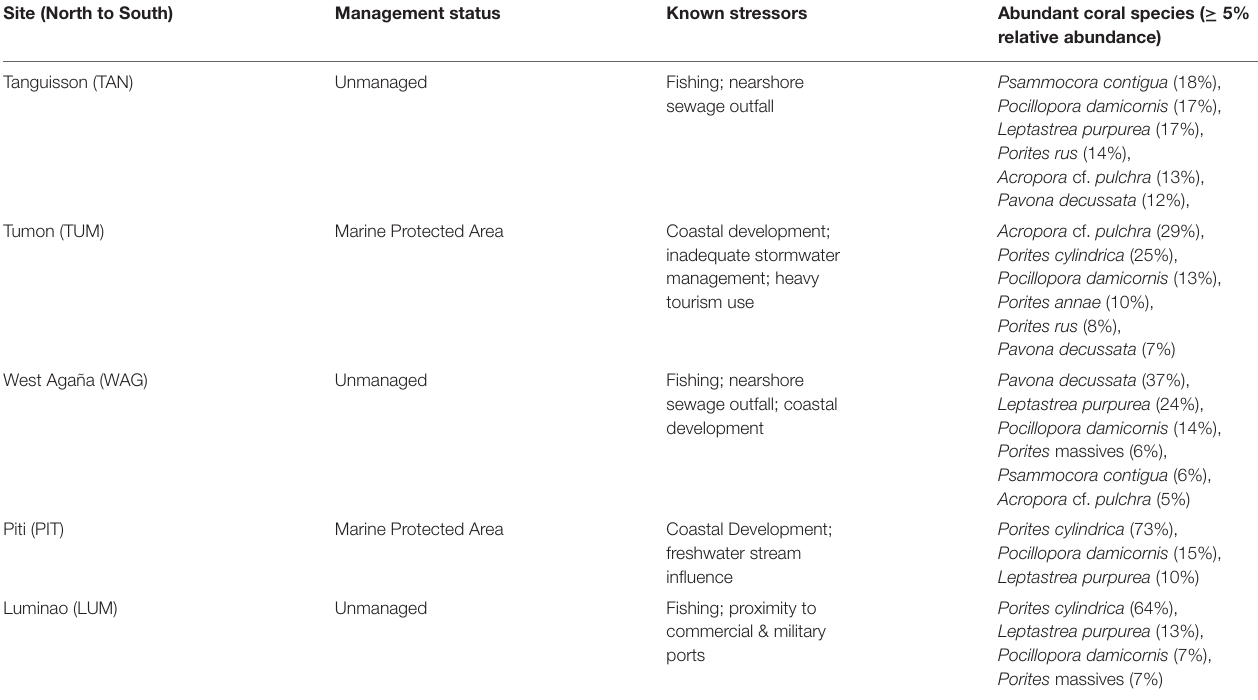
TABLE 1 | Characteristics of survey